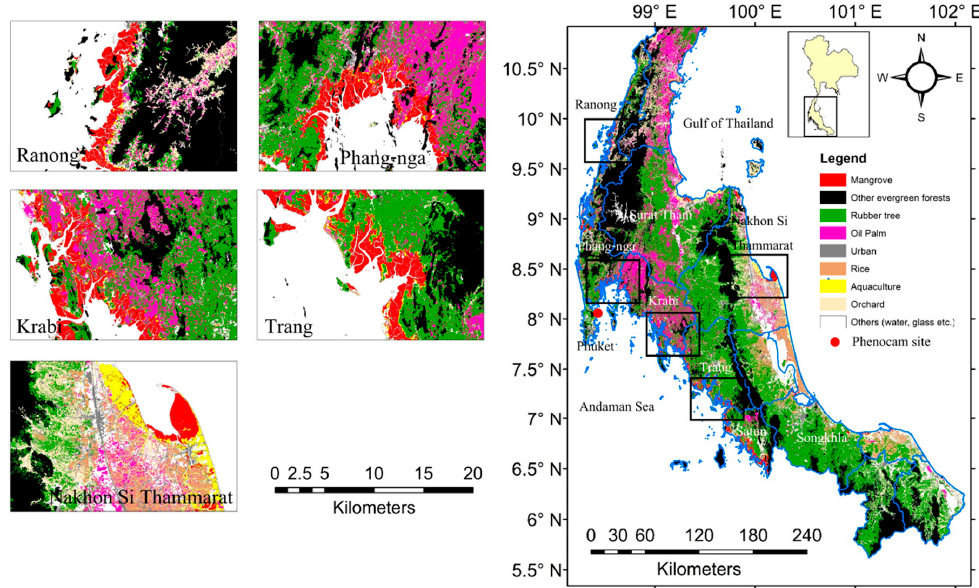
Figure 1. Land use and land cover of Southern Thailand and the location of five study sites: Ranong, Phang ‐ nga, Krabi, and Trang (all Andaman Sea sites) and Nakhon Si Thammarat province (the Gulf of Thailand site). Data from Land Development Department of Thailand (2012). The phenocam (red point) was mounted at Bangrong bay, Phuket province, Thailand (8.051724 ◦ N and 98.415384 ◦ E).